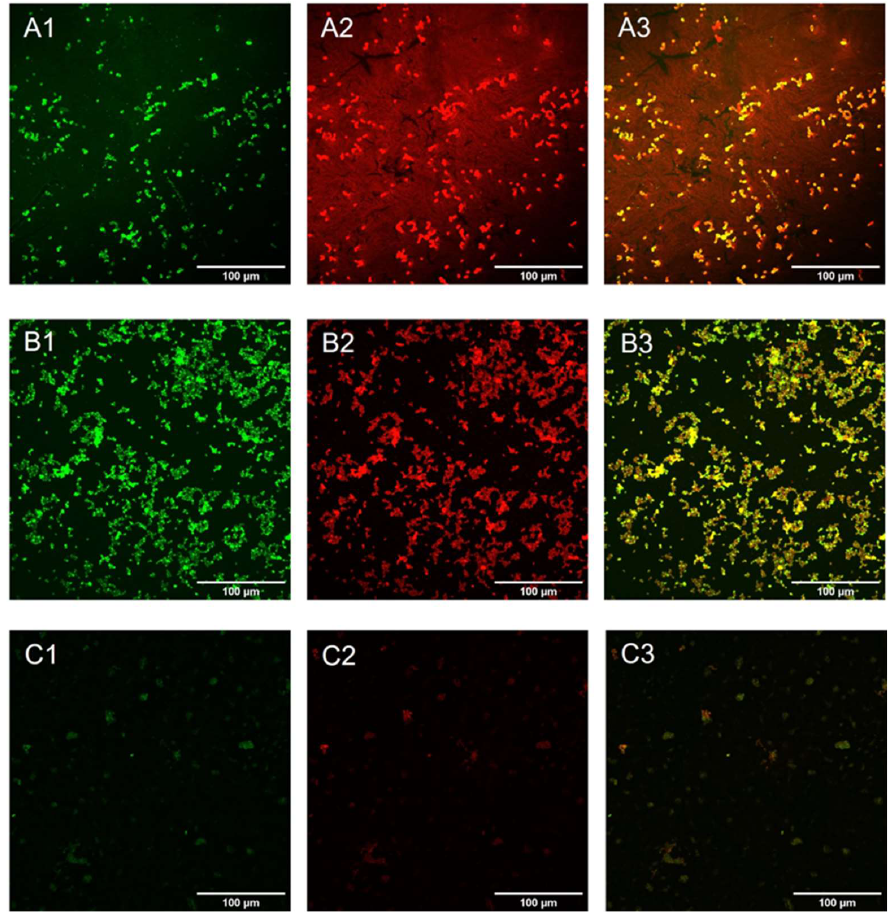
Figure 9. Confocal microscopy representative images of Candida biofilm cells grown on plastic ( A ), GO ( B ), and GO/CU ( C ) for 72 h. Cells were stained with Syto 9 ( A1 – C1 ) and ConcA ( A2 – C2 ). Images were merged ( A3 – C3 ) with ImageJ Fiji software. The scale bar is 100 µM.